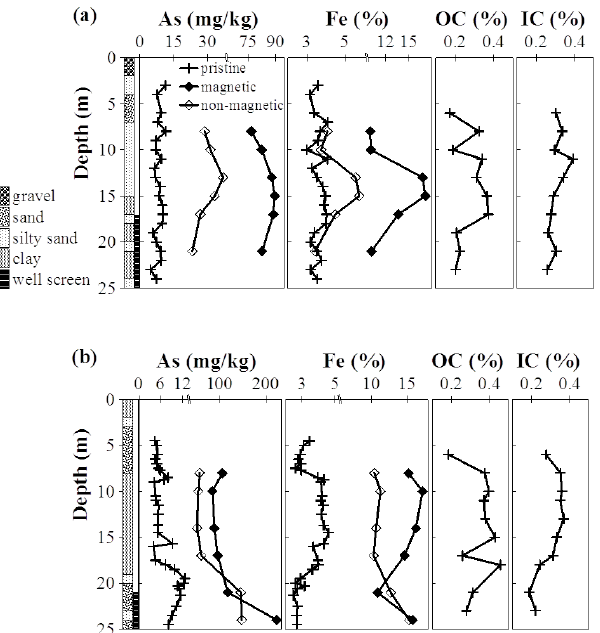
Fig. 4. Geochemistry distribution of As, Fe, and organic and inor- ganic carbon contents along the depth in (a) YL6-1 and (b) YL7-1. Solid crosses and diamonds represent untreated (pristine) samples and magnetic fractions, respectively. Hollow diamonds represent non-magnetic fractions. For magnetic and non-magnetic fractions, only As and Fe contents were